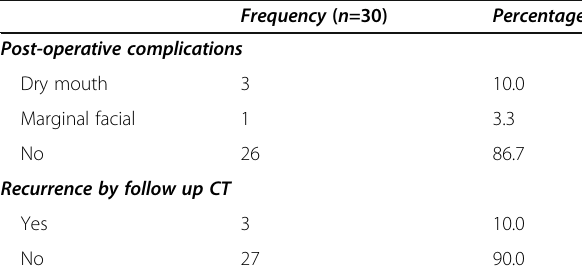
Table 3 Post-operative complications and